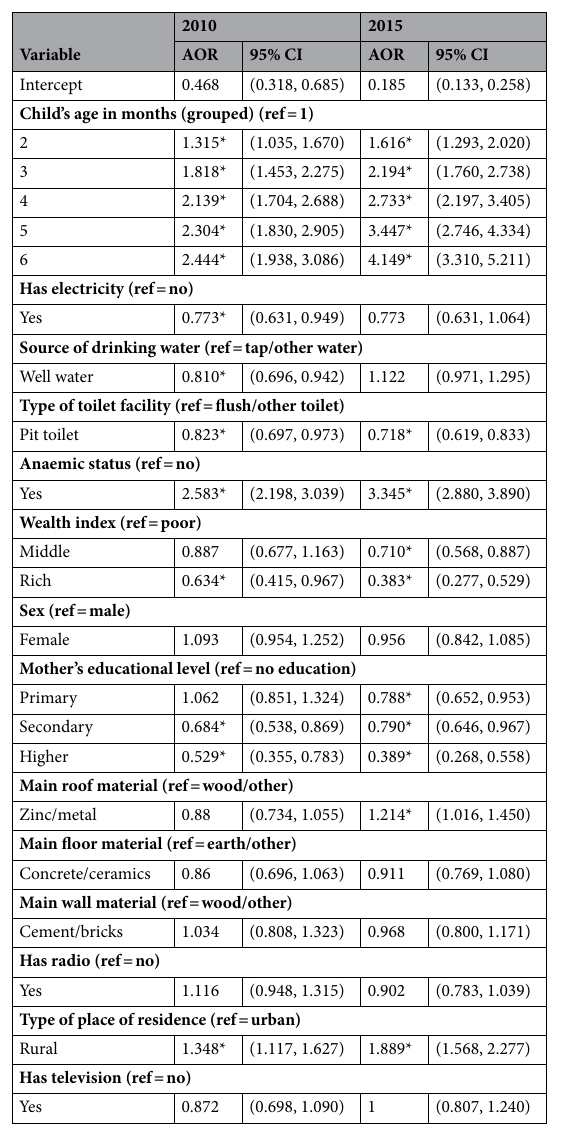
Table 4. 95% credible interval and adjusted posterior odd ratios estimates (AOR) of malaria. *means